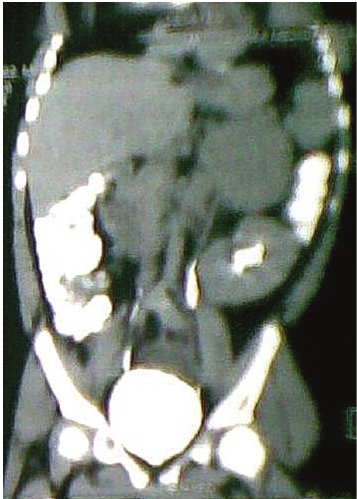
Figure 3: Contrast-enhanced abdominal computed tomography (CECT) scan in axial view revealed a large, well-circumscribed mildly enhancing adrenal mass ( 8 × 6 × 5 cm approx.) having few internal calcifications at left suprarenal region, which had displaced left kidney slightly downwards (arrow-mass; triangle-left kidney).